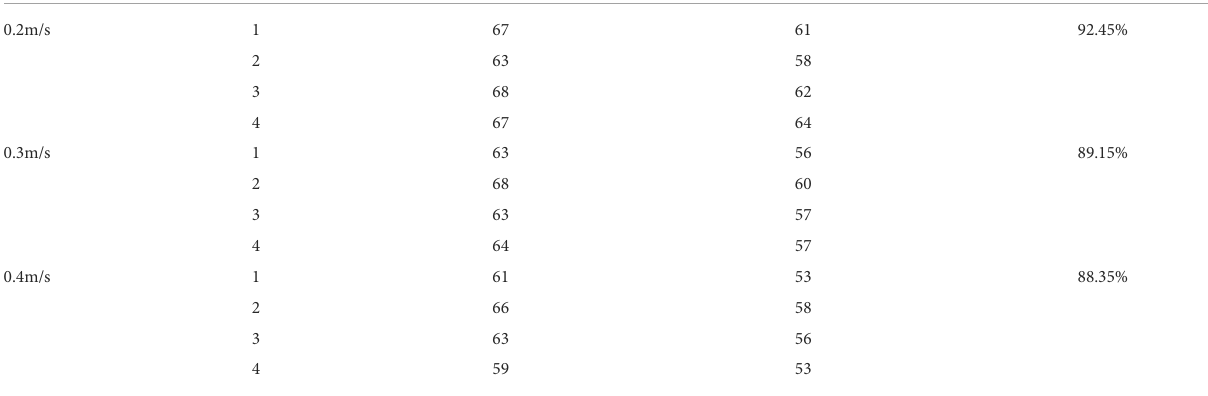
TABLE 2 Detection results of maize seedlings by weeding robot prototype.